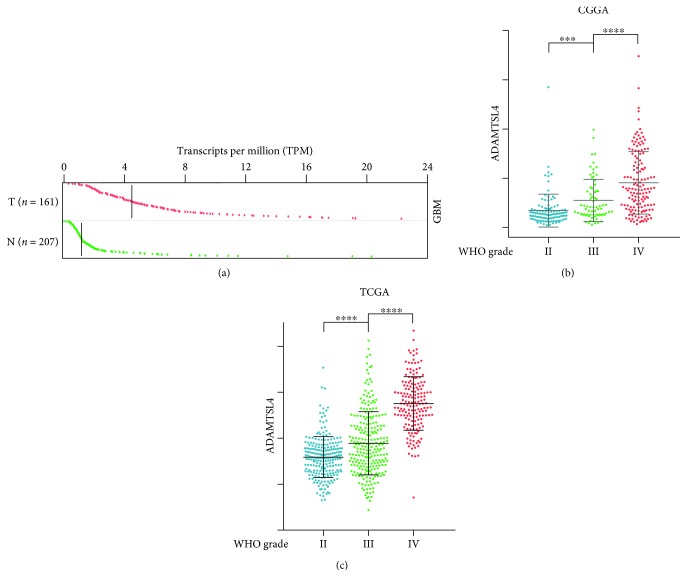
ADAMTSL4 was enriched in GBM (WHO grade IV). (a) ADAMTSL4 was significantly higher expressed in GBM (WHO grade IV) to normal brain tissue and analyzed by GEPIA website (T: GBM WHO grade IV tumor; N: normal brain tissue). (b, c) ADAMTSL4 expression is significantly upregulated along with the WHO grade in the CGGA database (b) and TCGA dataset (c). 109 WHO grade II, 72 WHO grade III, and 144 WHO grade IV patients in the CGGA database and 223 WHO grade II, 245 WHO grade III, and 168 WHO grade IV patients in the TCGA database. ∗∗∗ and ∗∗∗∗ indicate p < 0.001 and p < 0.0001, respectively.